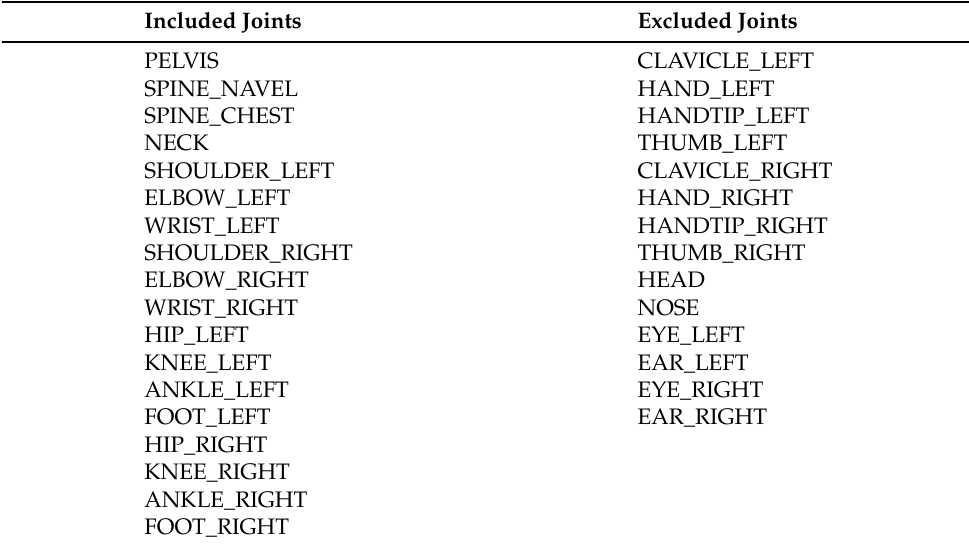
Table 1. Included and excluded joints from the Azure Kinect Body Tracking SDK joints in our analysis (for reference, see